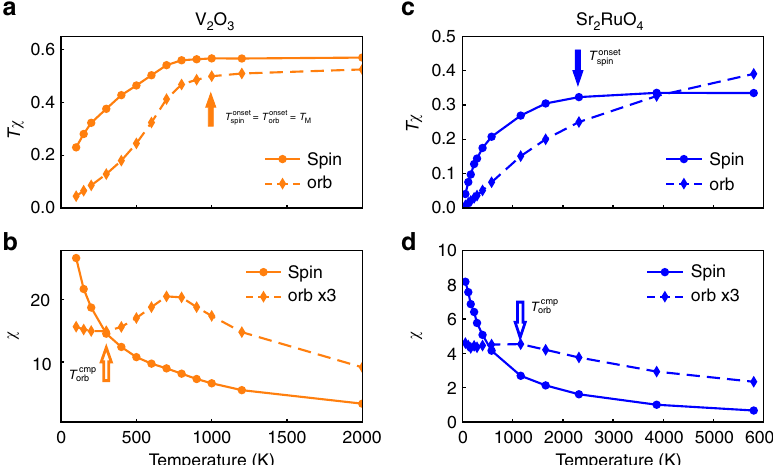
Fig. 4 The static local orbital and spin susceptibilities χ orb and χ spin plotted as functions of temperature. T χ and χ are shown in the upper and lower panels, respectively, for V 2 O 3 ( a , b ) and Sr 2 RuO 4 ( c , d ). The Curie law holds above 1000 K (indicated by fi lled orange arrow) in the spin and orbital susceptibility of V 2 O 3 ( a ). In Sr 2 RuO 4 the spin susceptibility follows Curie-like behavior above 2300 K (indicated by fi lled blue arrow), while the orbital susceptibility does not follow a Curie law in the temperature range studied ( c ). The spin susceptibility of both materials ( b , d ) does not saturate at the lowest accessible temperature, indicating an even lower Fermi-liquid scale. The orbital susceptibility has only weak temperature dependence below 300 K in V 2 O 3 ( b ) and below 1100 K in Sr 2 RuO 4 ( d ) (indicated by open orange and blue arrows,